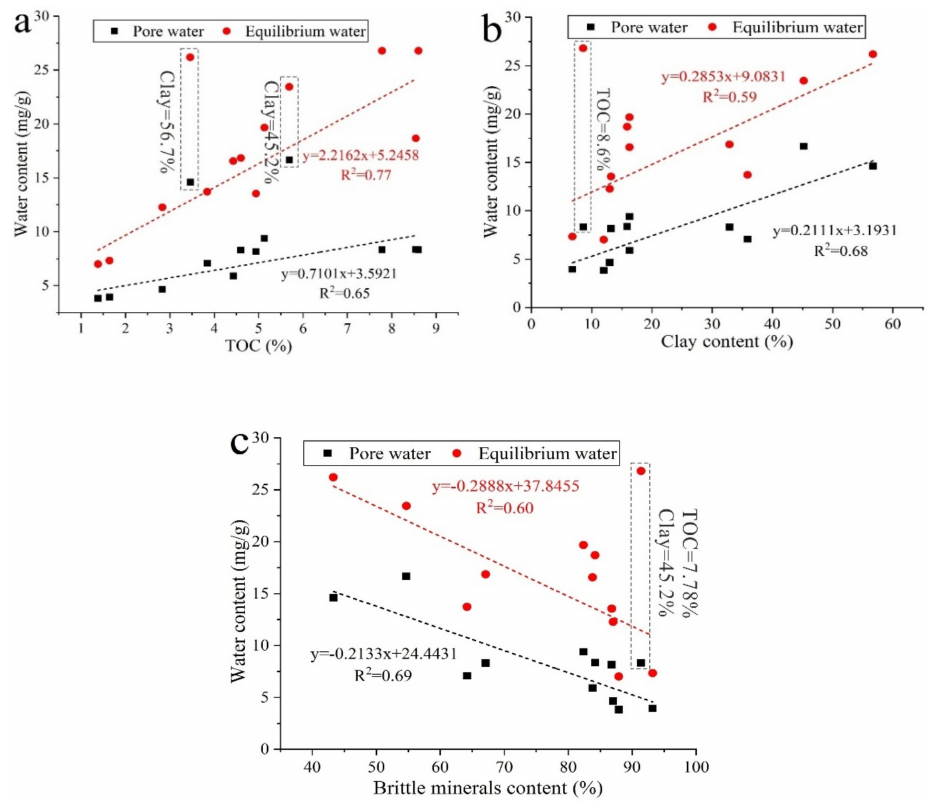
Figure 4. Relationships between pore water contents and TOC ( a ), clay ( b ) and brittle mineral ( c ) contents.